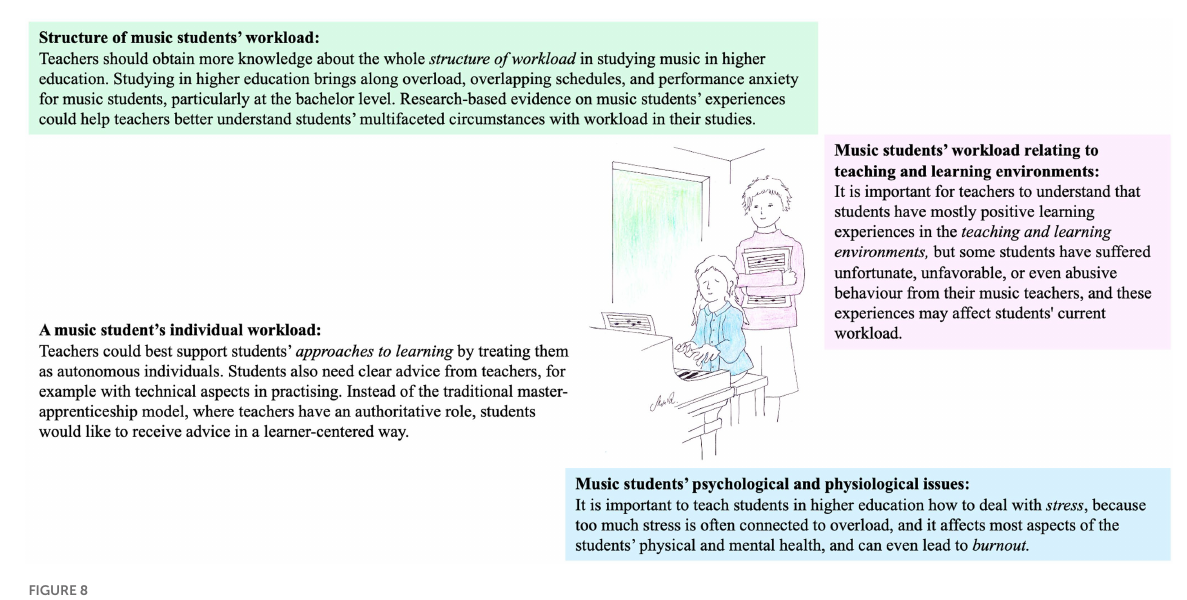
FIGURE 8 Examples of recommendations in four categories as tools for teachers to support music students in managing and coping with their workload in higher